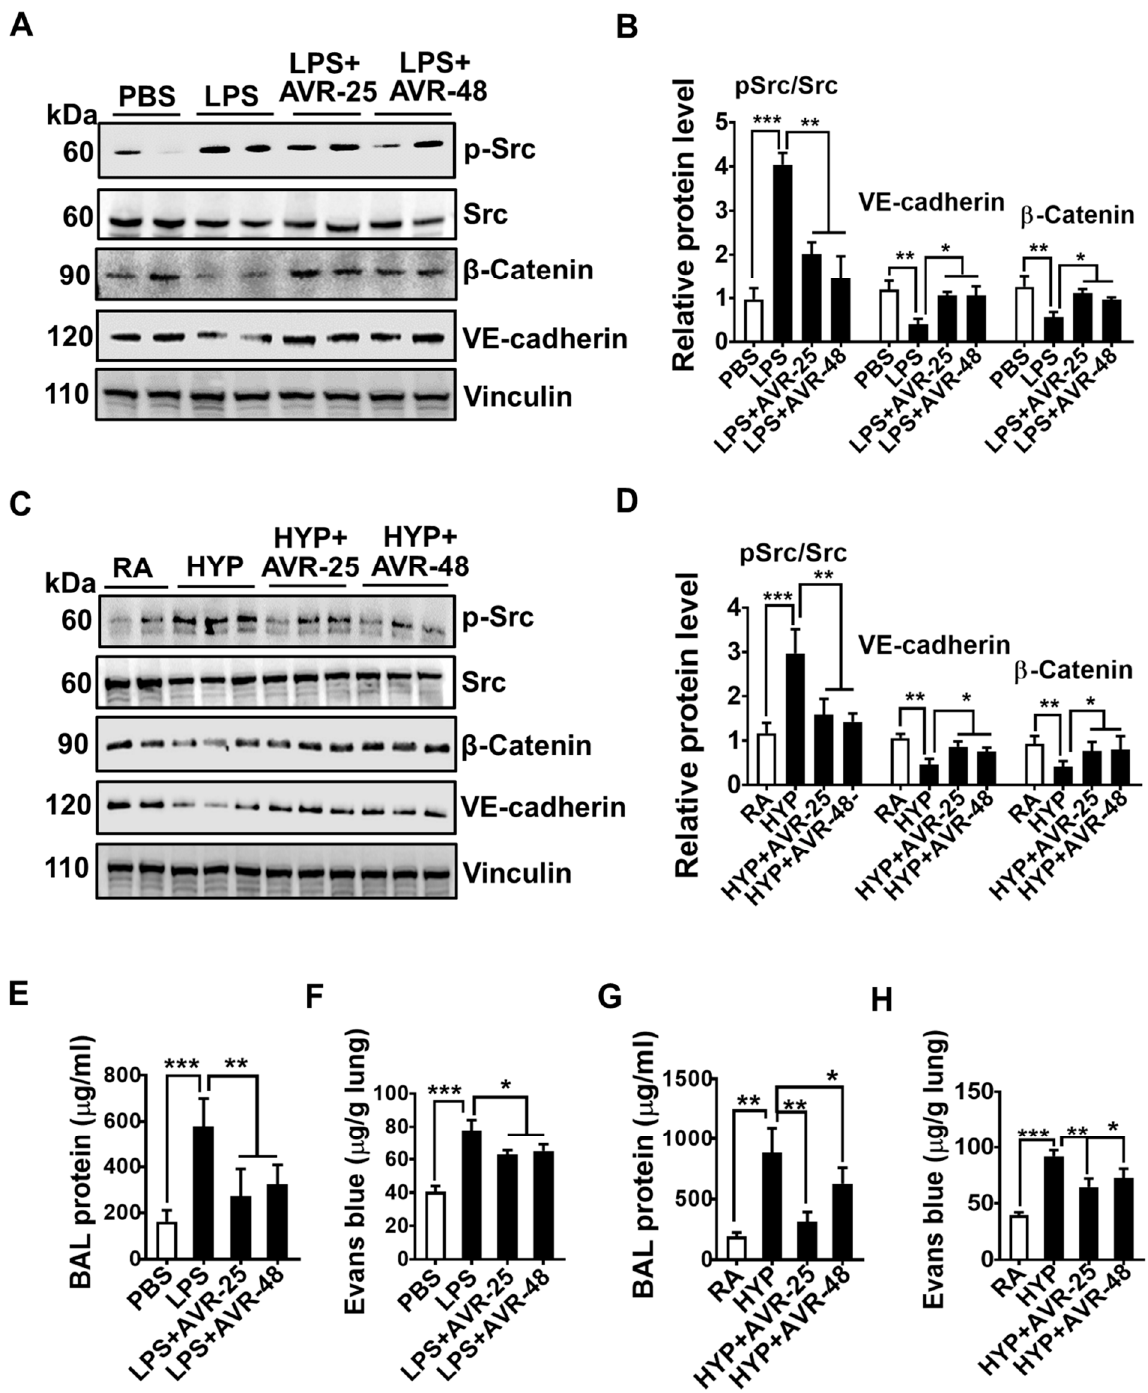
Figure 4. AVR-25 or AVR-48 treatment to LPS- and hyperoxia-induced ALI mice showed an improved endothelial barrier function. ( A , C ) Western blotting showing expression of junctional adherence proteins VE-cadherin, β -catenin, and Src in lungs of LPS- and hyperoxia-induced lung injury in mice treated with or without AVR-25 or AVR-48. ( B , D ) Densitometric quantification of the immunoblots ( n = 4–6, * p < 0.05 ** p < 0.01 and *** p < 0.001). ( E – H ) Pulmonary edema as measured by total protein concentration in the BALF and Evans Blue dye concentration in the lungs of LPS- and hyperoxia-induced lung injured mice ( n = 5–6, * p < 0.05 ** p < 0.01 and *** p < 0.001). Data are expressed as mean ± SEM. For statistical analysis, student’s unpaired t -test and one-way analysis of variance (ANOVA) followed by Tukey post hoc analysis were used. LPS: lipopolysaccharide; ALI: acute lung injury; BAL: bronchoalveolar lavage fluid; PBS: phosphate buffered saline; RA: room air; HYP: